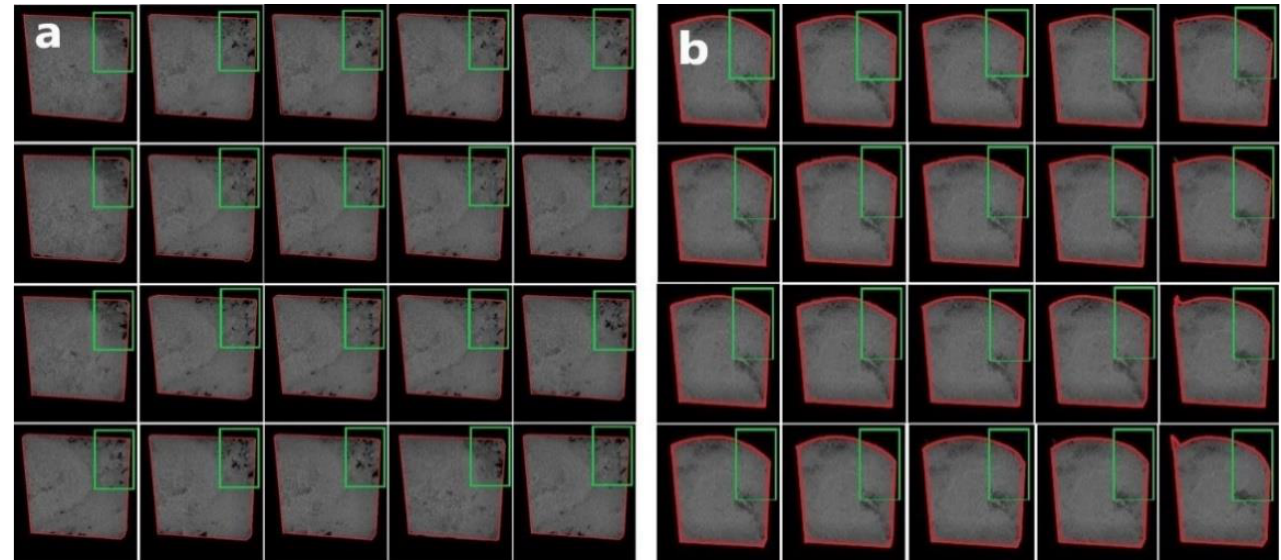
Figure 10. Evidence of location learning using Custom Object CNN: ( a ) Sample CT scan images with manually identified regions containing the possible pores and fractures of the rock used as training samples; ( b ) In return, the Custom Object CNN identifies the same regions (as in ( a )), eventhough very few pores are located. This case is a classic example of mode collapse. One possible solution to the mode-collapse problem is minibatch learning; however, this approach might fail in the absence of a large and diverse sample image dataset. To combat this problem, we increased the diversity while preparing the training samples for Custom Object CNNs, but this policy fails because of the lack of variety within the current dataset. In figures, a and b, the image boundaries are marked in red.